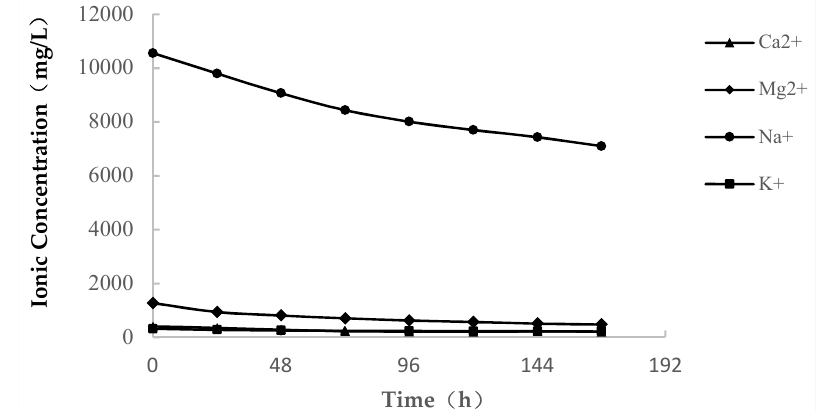
Figure 3. Concentration change curves of the main cations after seawater immersion.